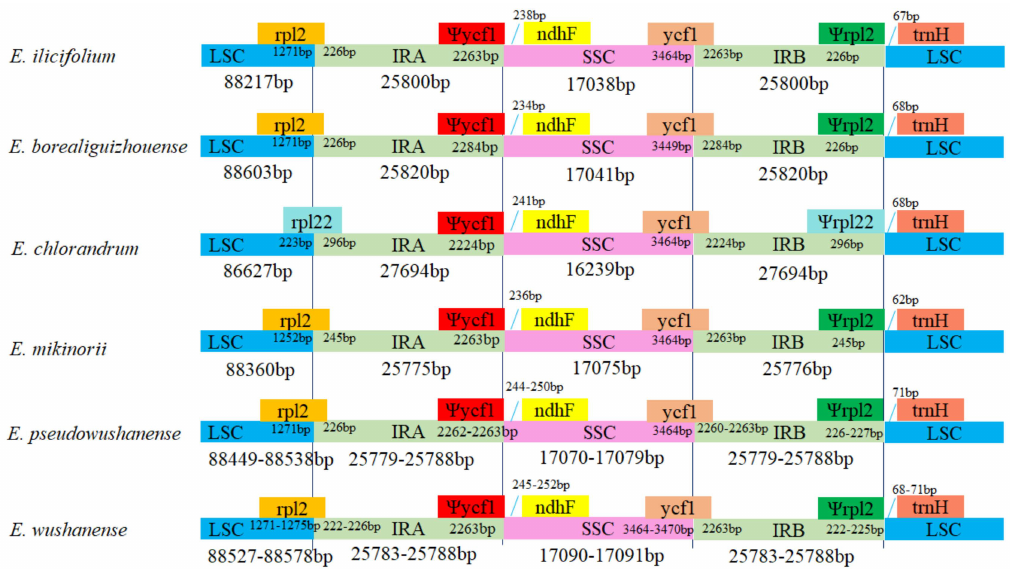
Figure 2. Comparison of the borders of the LSC, SSC and IR regions among plastid genomes of E. wushanense and its closely related